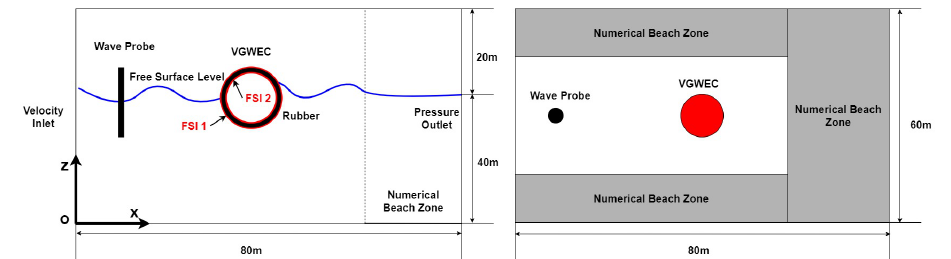
Figure 1. Computational domain